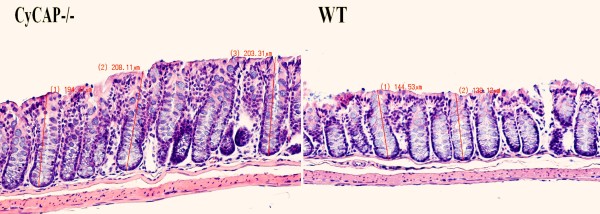
The CyCAP-/- mice spontaneously develop colonic mucosal hyperplasia early in life at 6–8 wk. The difference between this hyperplastic mucosa and normal mucosa of the WT mice is inconspicuous by superficial observation, but statistically, the difference is significant (p < 0.0001, T-test) (20 × magnification, H&E).